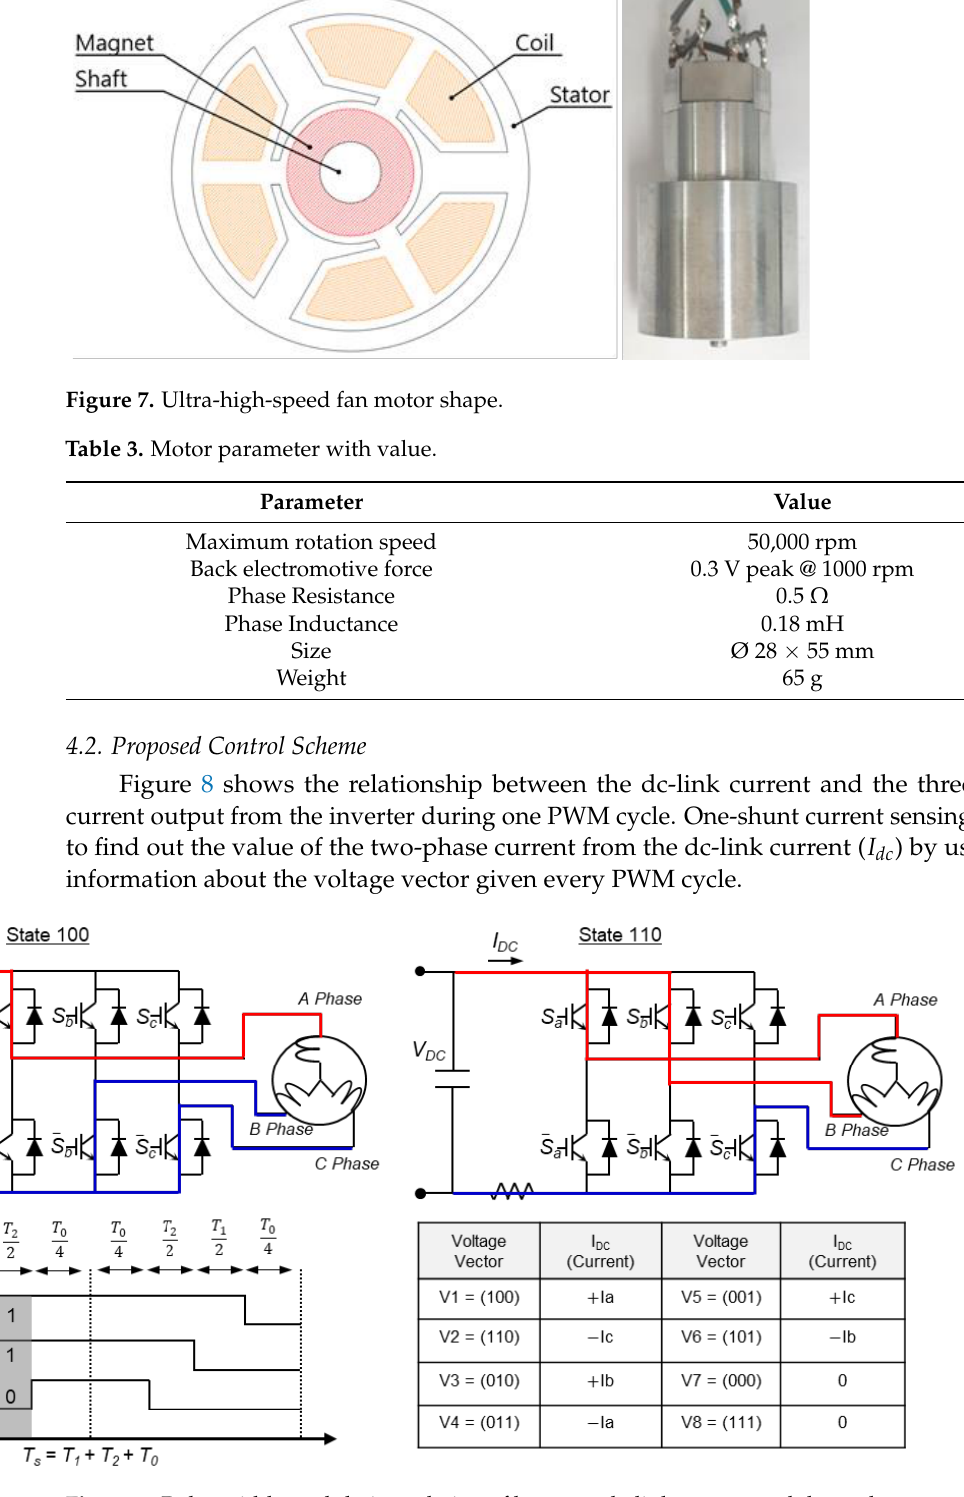
Figure 8. Pulse width modulation relation of between dc-link current and three phases current.